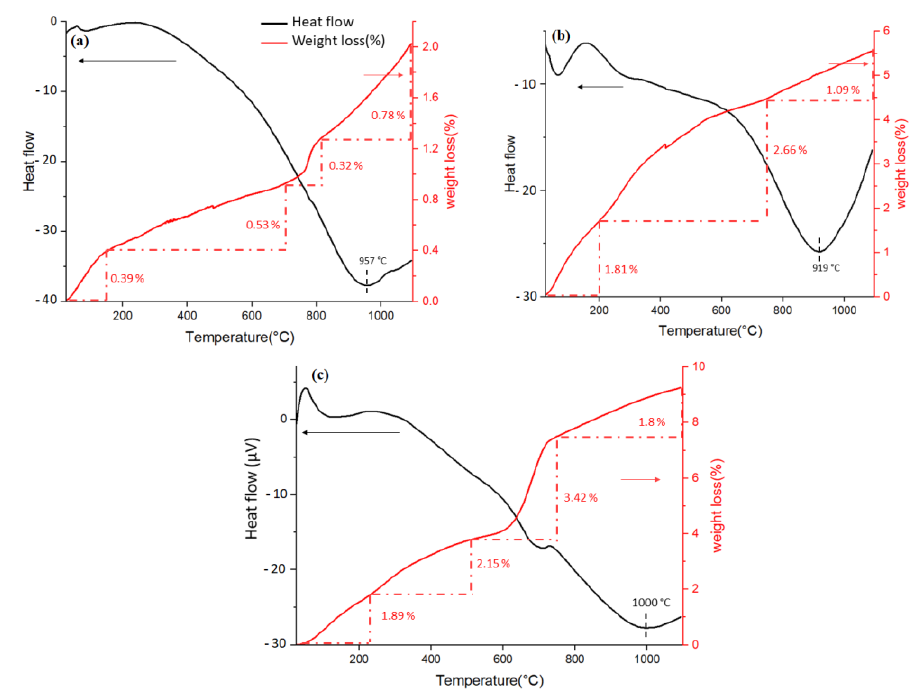
Figure 10. TGA-DSC profiles for non-calcined ( a ) HAp-D, ( b ) HAp-S and ( c ) HAp-R. For these samples, the large, broad endothermic peak at the range of 900 to 1100 °C suggests a phase transition of HAps to other apatites such as OCP, DCP, and TCP, mean- ing that the chosen calcination temperature (700 °C) was